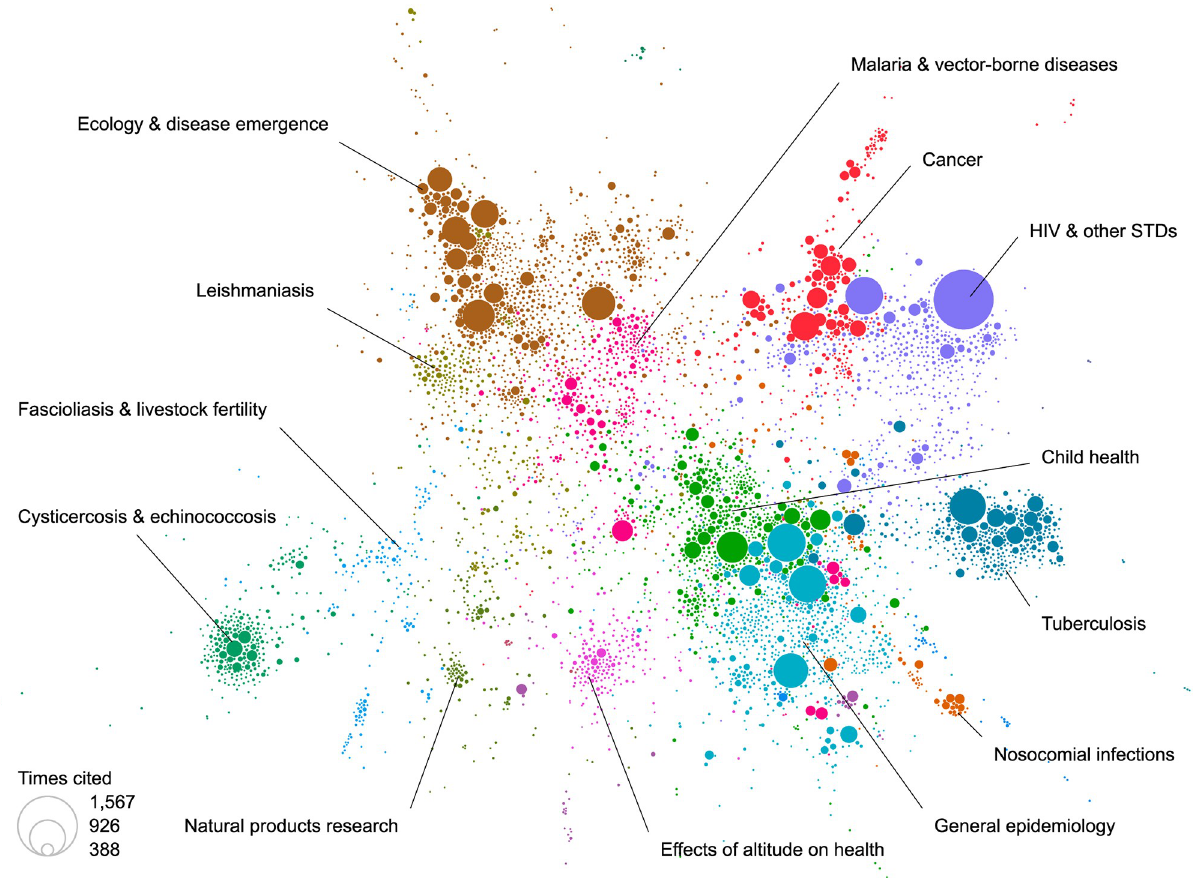
Fig 3. Bibliographic coupling network of Peruvian publications. In this network, circles represent articles, circle size indicates the article’s citation count, circle color indicates the article’s topic, and circle position indicates the article’s similarity to other articles in the network. The largest dot with > 1500 citations was a multi-centered international HIV clinical trial where a Peruvian investigator was a